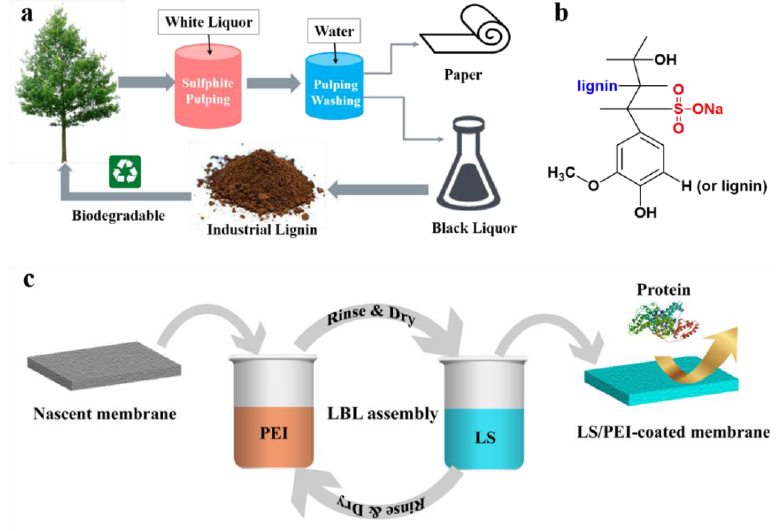
Figure 1. ( a ) Schematic diagram for chemical pulp production; ( b ) Structural diagram of sodium lignosulfonate (LS); ( c ) Schematic illustration of the LbL deposition of sodium lignosulfonate and polyethyleneimine (LS / PEI) for antifouling membrane surfaces.